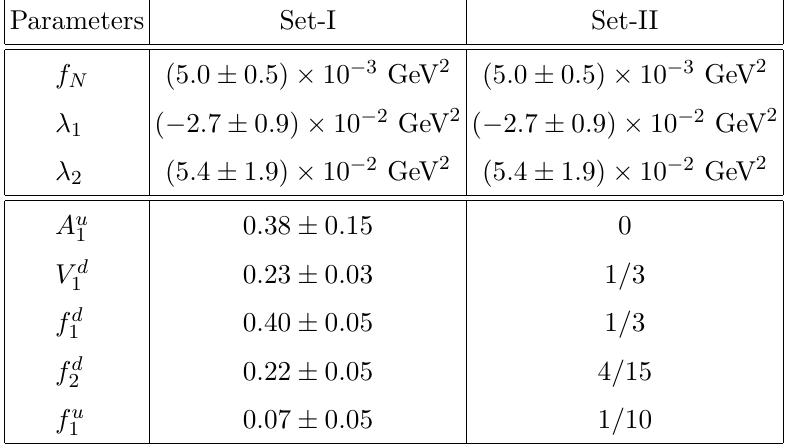
Table 1 . The numerical values of the main input parameters entering the expressions of the nucleon’s DAs. The upper panel shows the dimensionfull parameters the nucleon. In the lower panel we list the values of the five dimensionless parameters that determine the shape of the